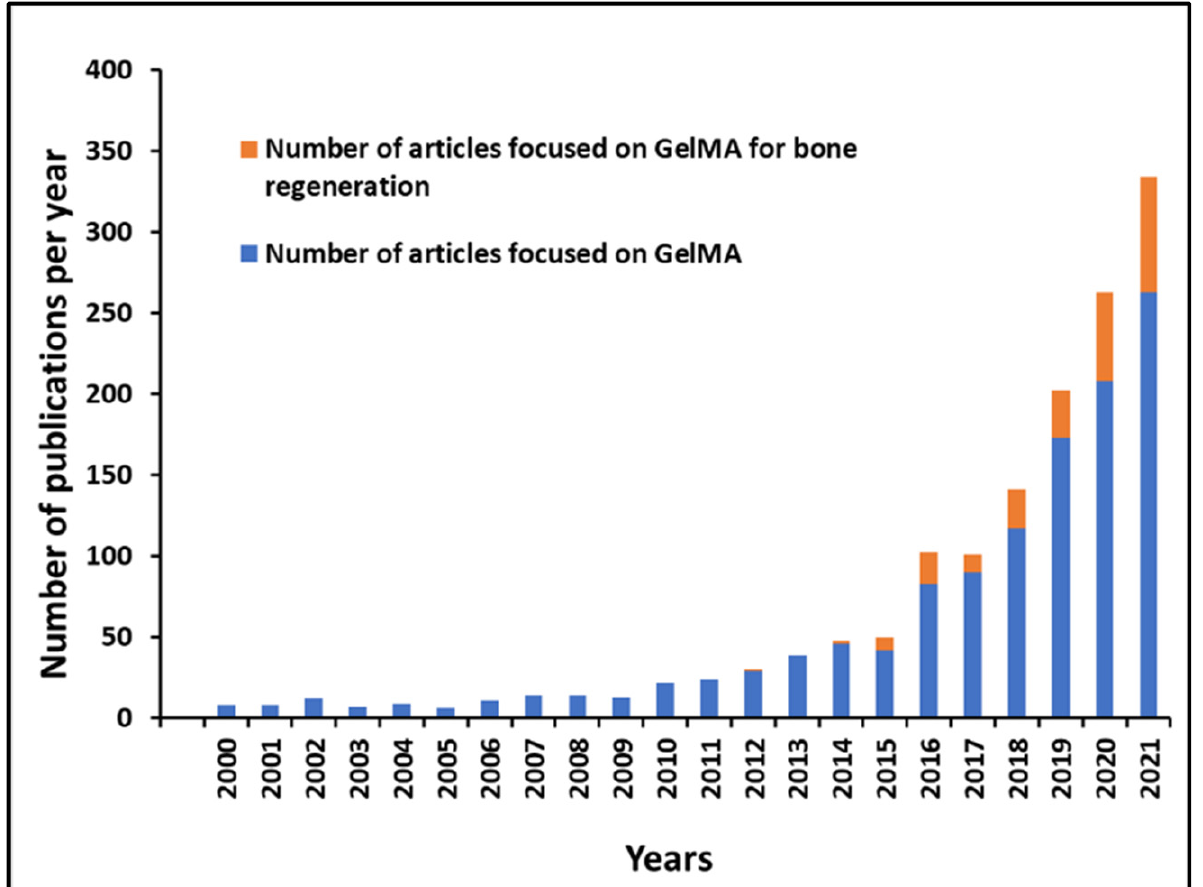
Figure 1. Number of articles focused on GelMA and GelMA for bone regeneration published per year since 2000 according to PubMed.